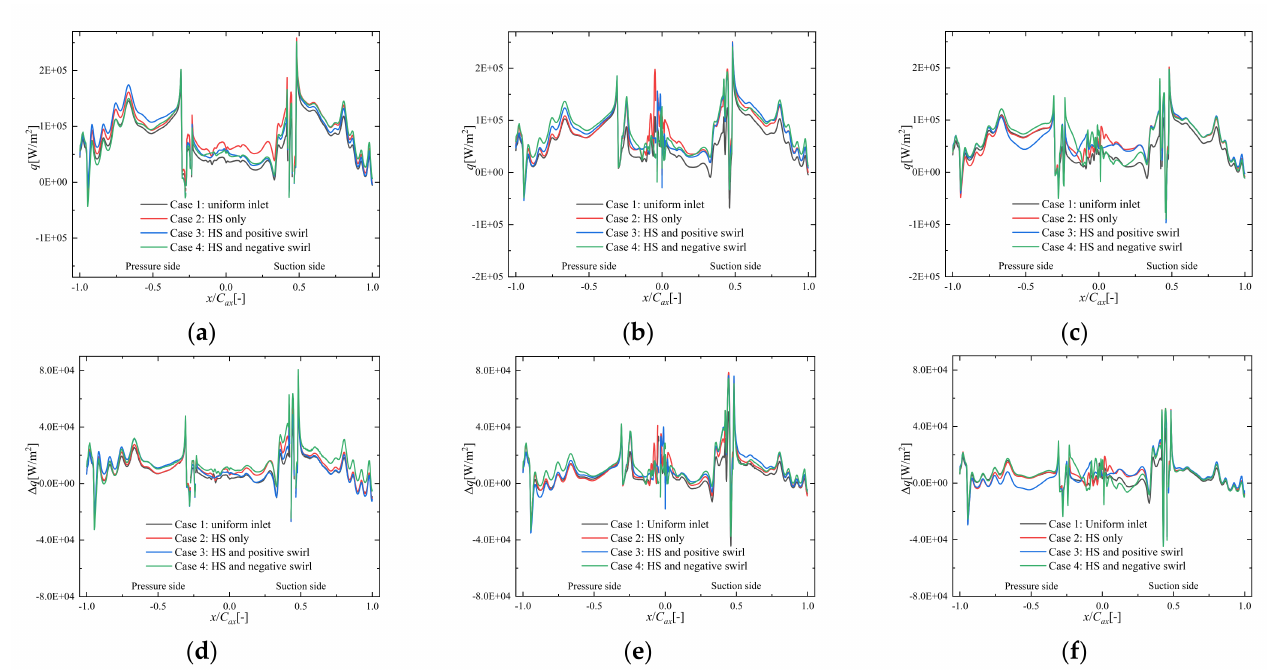
Figure 16. Local heat flux and heat flux drop distribution along the vane surface. ( a ) local heat flux at z = 25% span; ( b ) local heat flux at z = 50% span; ( c ) local heat flux at z = 75% span; ( d ) heat flux drop distribution at z = 25% span; ( e ) heat flux drop distribution at z = 50% span; ( f ) heat flux drop distribution at z = 75%